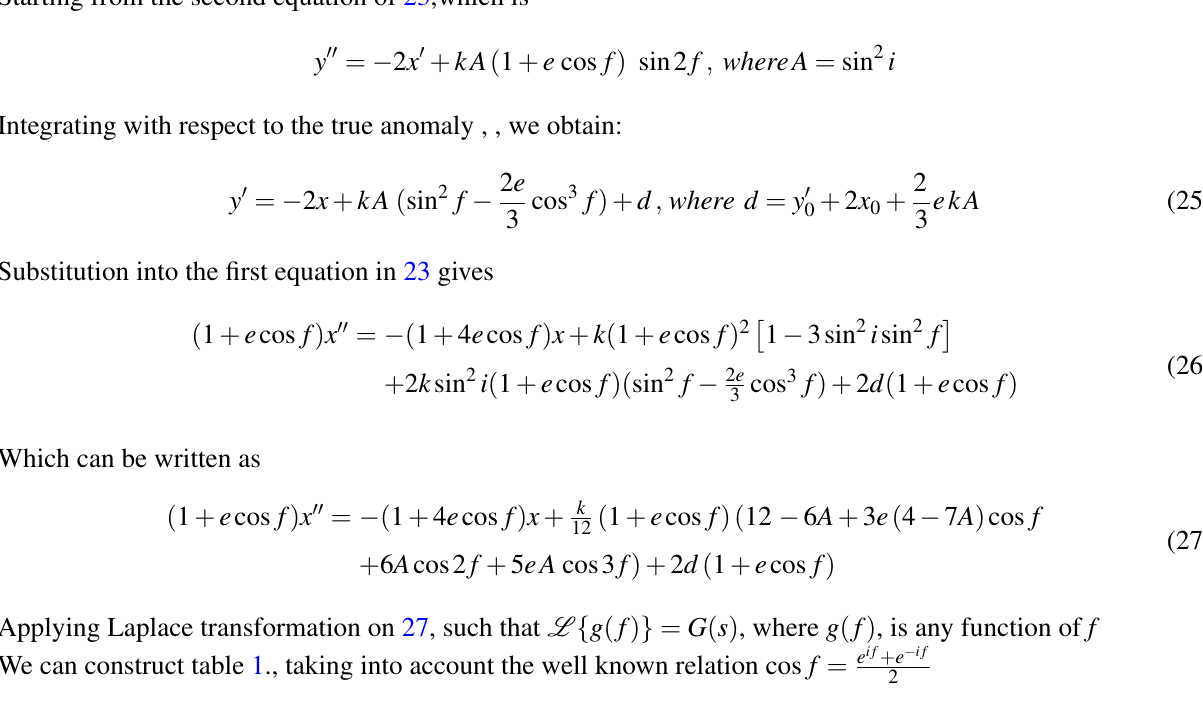
Table 1 Laplace transformation on the relative equation of motion of the Deputy in